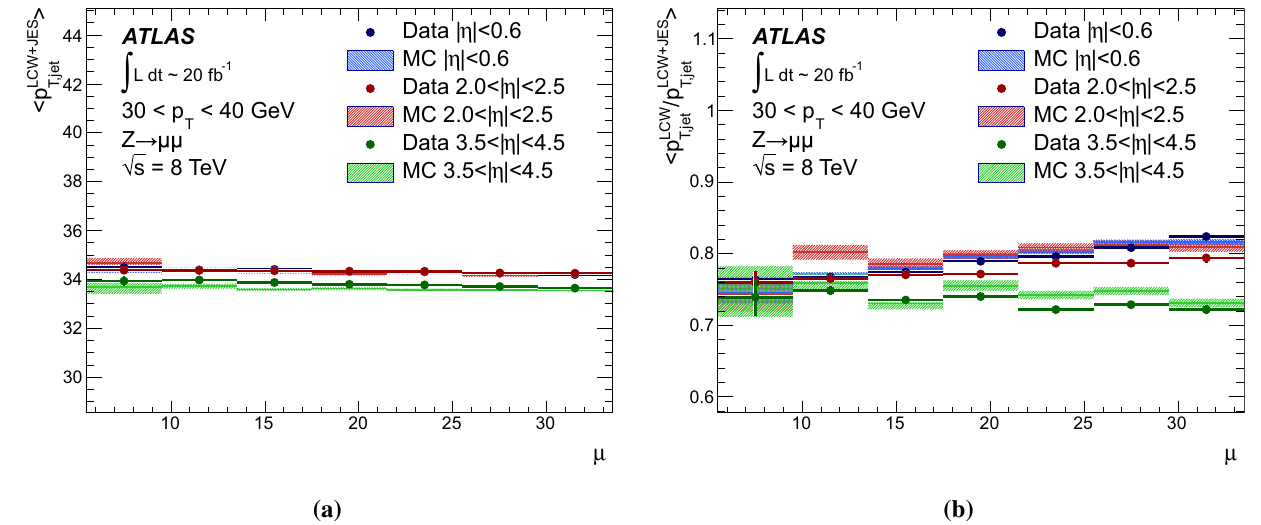
μ dependence of the uncorrected jet p Fig. 30 In a , the fully calibrated and corrected jet p T response mea- T response is shown in b . It sured by p LCW + JES is measured in terms of its ratio to the fully calbrated jet response, is shown as a function of the pile-up activity mea- T , jet / p LCW + JES (μ) , for the same events and in the same detector p LCW sured by μ , in three different detector regions for Z → μμ events with T , jet T , jet < 40GeV, one anti- k t jet with R = 0 . 4 with 30GeV < p LCW + JES regions. The shaded bands shown for the results from MC simulations T , jet indicate statistical uncertainties for 2012 data and MC simulations with fully simulated pile-up. The